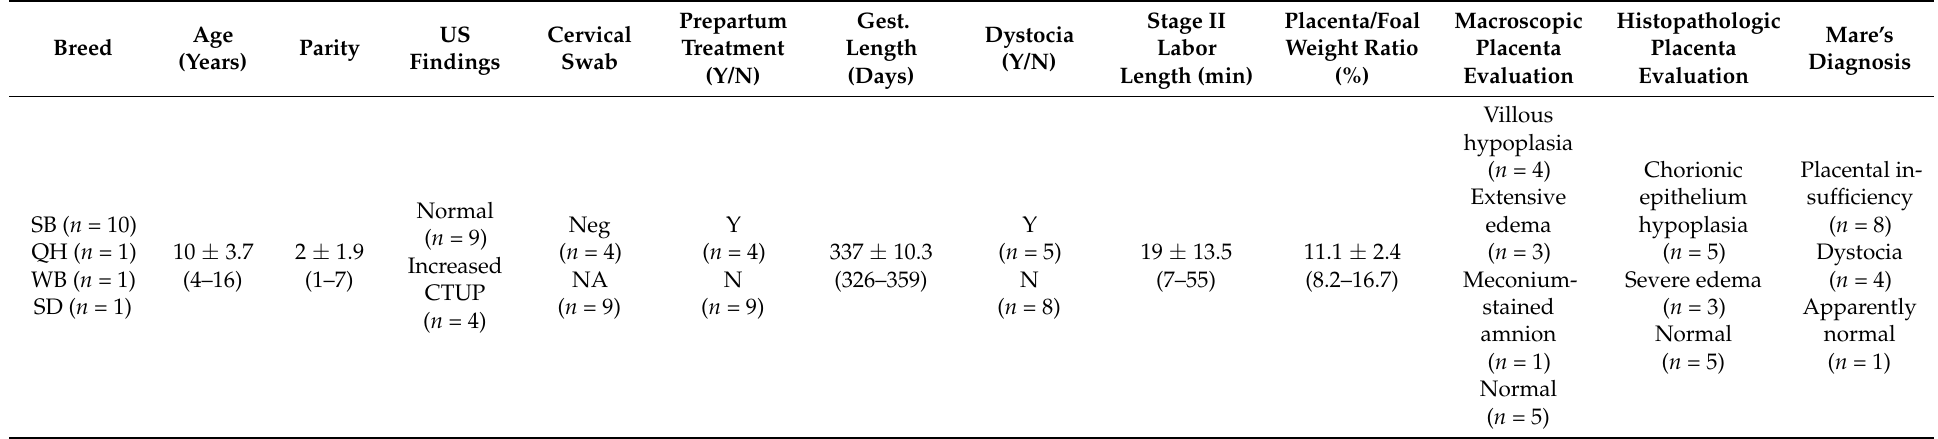
Table 2. Clinical and histopathological data collected from the 13 mares hospitalized for attended parturition (group NE). SB = Standardbred; QH = Quarter Horse; WB = Warmblood; SD = Saddlebred; US = ultrasonographic; CTUP = transrectal combined thickness of the uterus and placenta; NA = data not available. Data are expressed as mean ± standard deviation